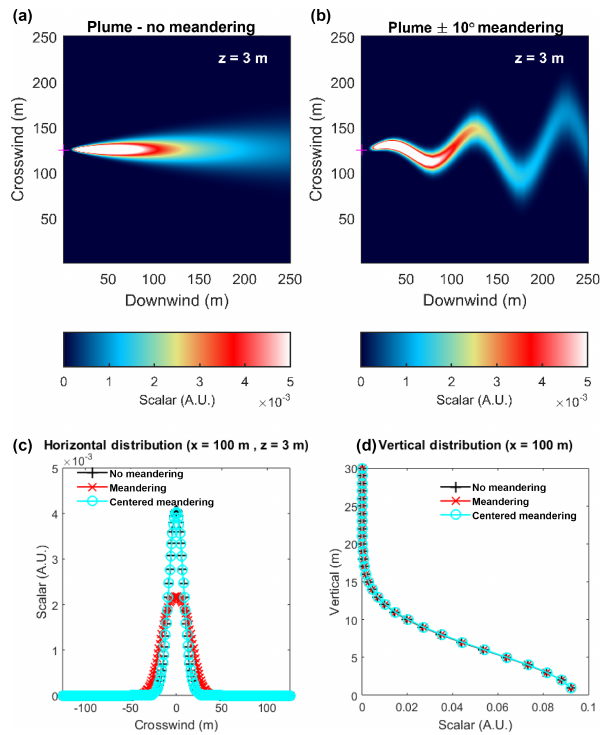
Figure 8. A theoretical site with an additional plume meandering scale added shown in a top-down view at 3m of the (a) Gaussian plume with no meandering and (b) instantaneous Gaussian plume with 10 ◦ meandering. The comparison of (c) horizontal distribu- tions of concentration and (d) vertical distributions of concentra- tions for three scenarios (no meandering, averaged meandering and centered meandering) are also shown. All units are